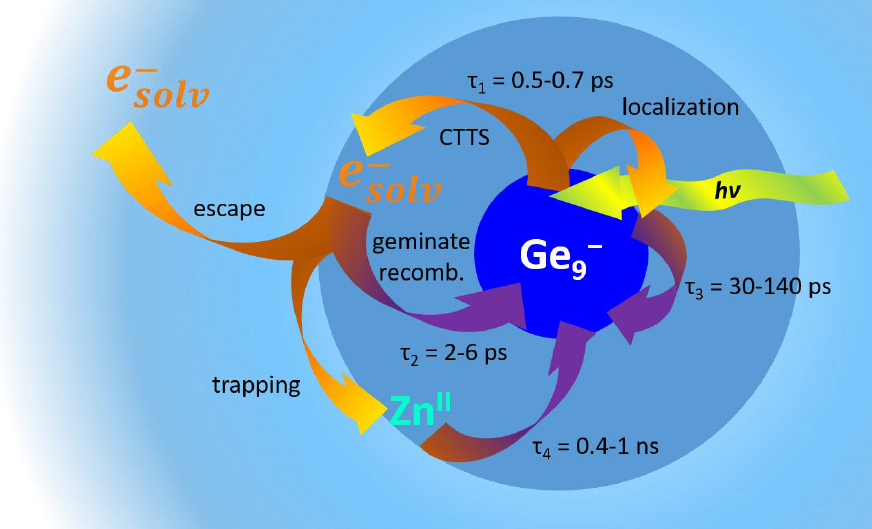
Figure 8. Illustration on the processes after photoexcitation (hν) of the Ge 9− -cluster compounds. Recombination processes are depicted as violet arrows all other processes in orange.